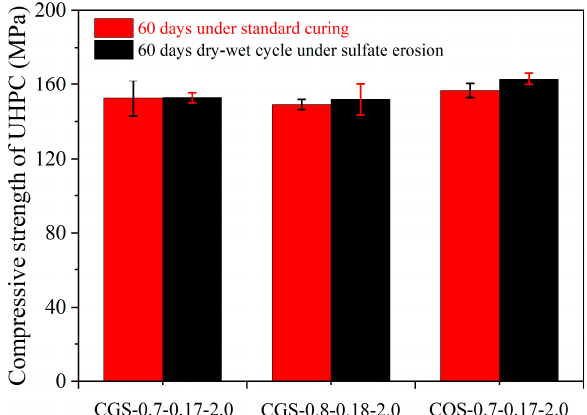
Figure 12. The compressive strength of the UHPC after standard curing or dry–wet cycles under sulfate erosion.